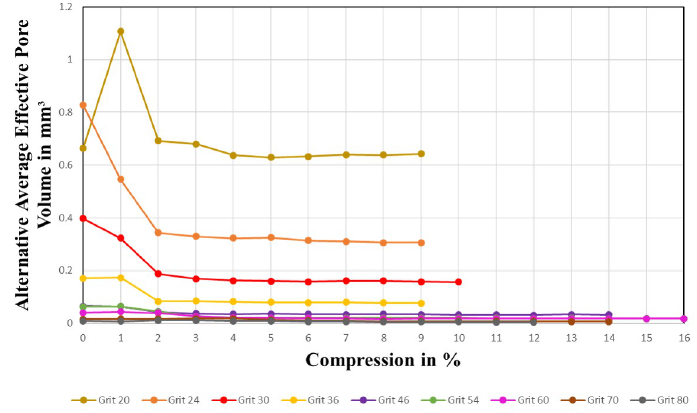
Figure 24. Alternative average effective pore volume in comparison to different percentages of compression.